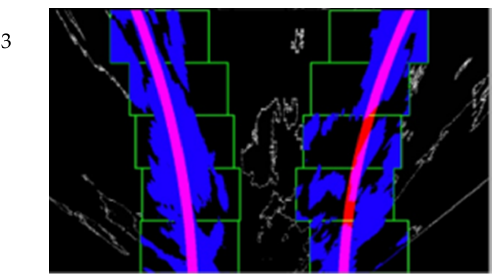
Figure 5. Rows are detected by using depth map ( 1 ); transformed binary depth map at the center ( 2 ); while lower image ( 3 ) represents the sliding window detection of the rows.